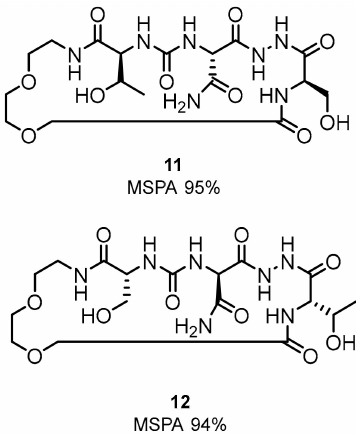
Figure 7. Examples of the macrocyclic peptidomimetic compounds 11 and 12 with glycol-derived linker.